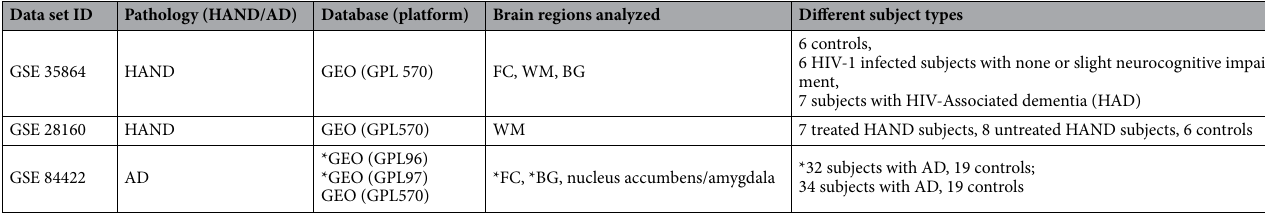
Table 1. Gene expression data summary. FC: Frontal Cortex, WM: White Matter, BG: Basal Ganglia. The asterisks are used to signify that both GPL 96 and GPL97 contain data from 32 subjects with AD and 19